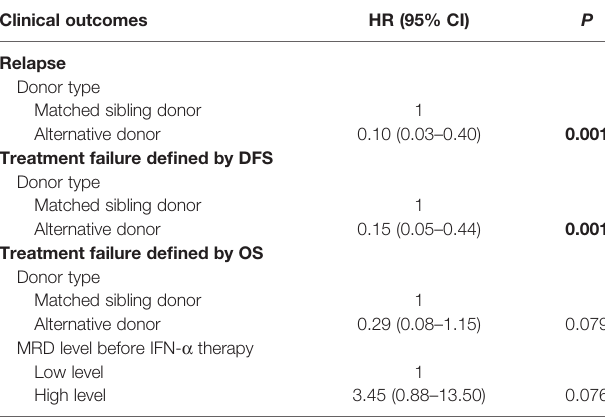
TABLE 3 | Multivariable analysis of prognostic factors for preemptive IFN- a therapy. Clinical